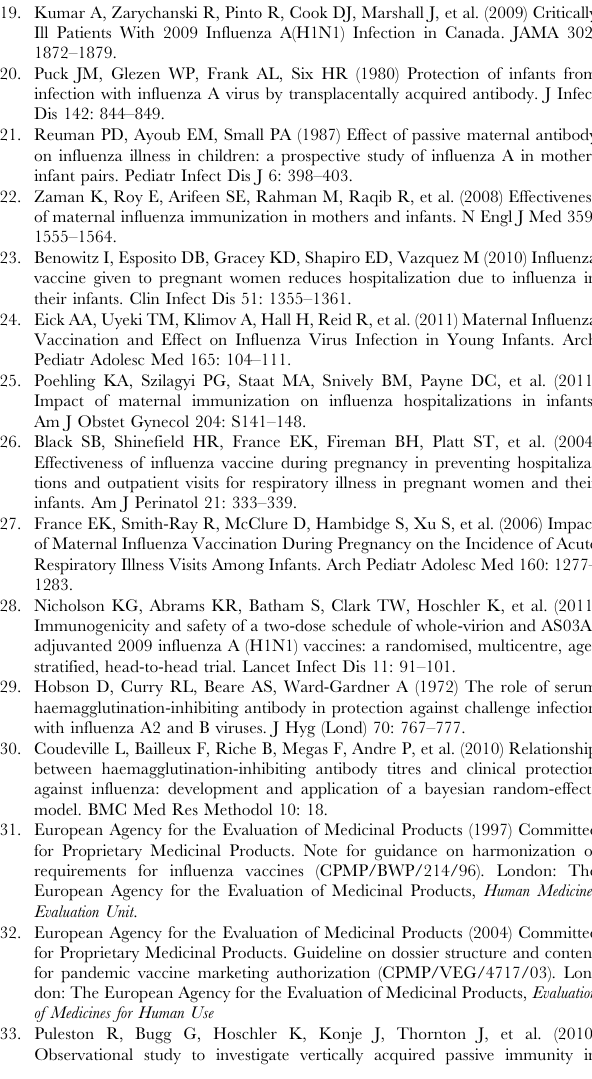
Figure S1 Scatter-plot of haemagglutinination inhibi- tion against microneutralization titres. (Titres are ex- pressed as reciprocal of the dilution and are given on a log 2